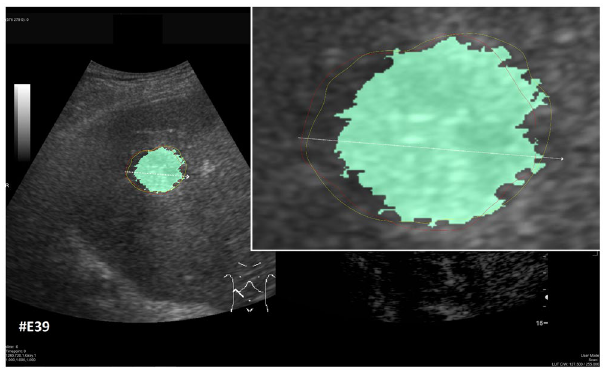
Figure 16. Direct comparison of our approach with GrowCut (green) for case 39. The red outline represents the manual segmentation including the white arrow representing the manually drawn maximum diameter. The yellow line represents the result of the semi-automatic segmentation (see also Fig. 11). Compared with the manual segmentation, our semi-automatic segmentation algorithm could achieve a DSC of 92.47%. However, compared with the manual segmentation, the GrowCut-based segmentation achieved a DSC of